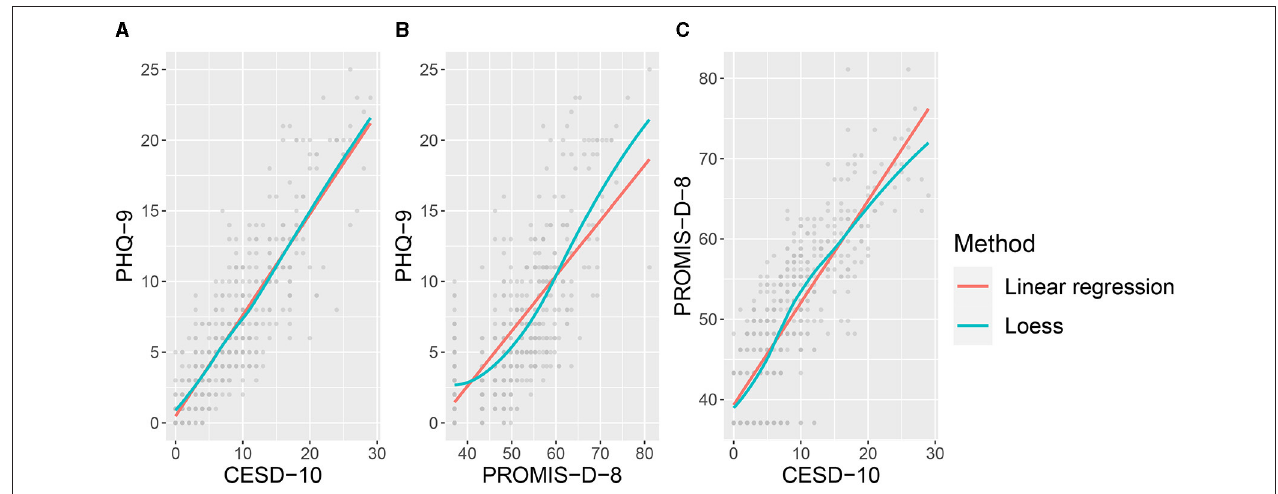
FIGURE 3 | Figures A–C depict the pairwise scatterplots of the three questionnaires (i.e. PHQ-9, CESD-10 and PROMIS-D-8) that are the indicators for the latent variable depression. The scatterplots reveal deviations from linearity for the scatterplots depicting the